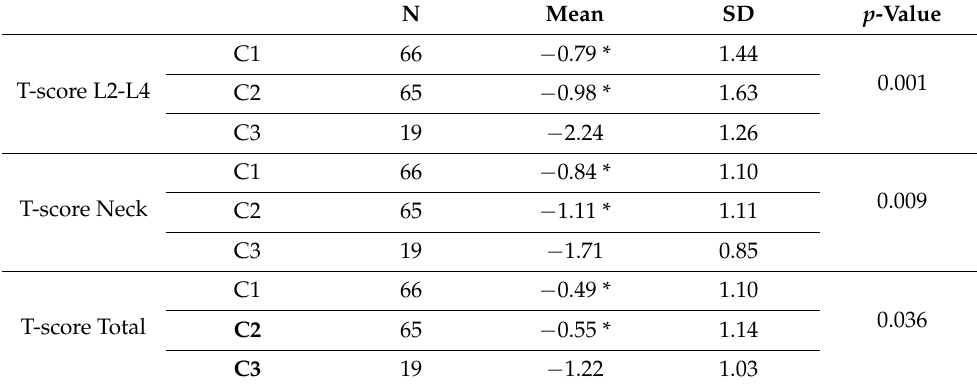
Table 4. Comparison of T-score at different areas among MCI categories.